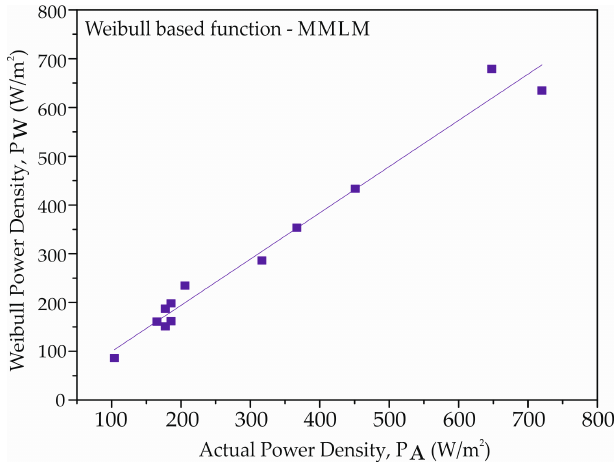
Figure 1. Scattered plot between calculated Weibull power density and actual power density.